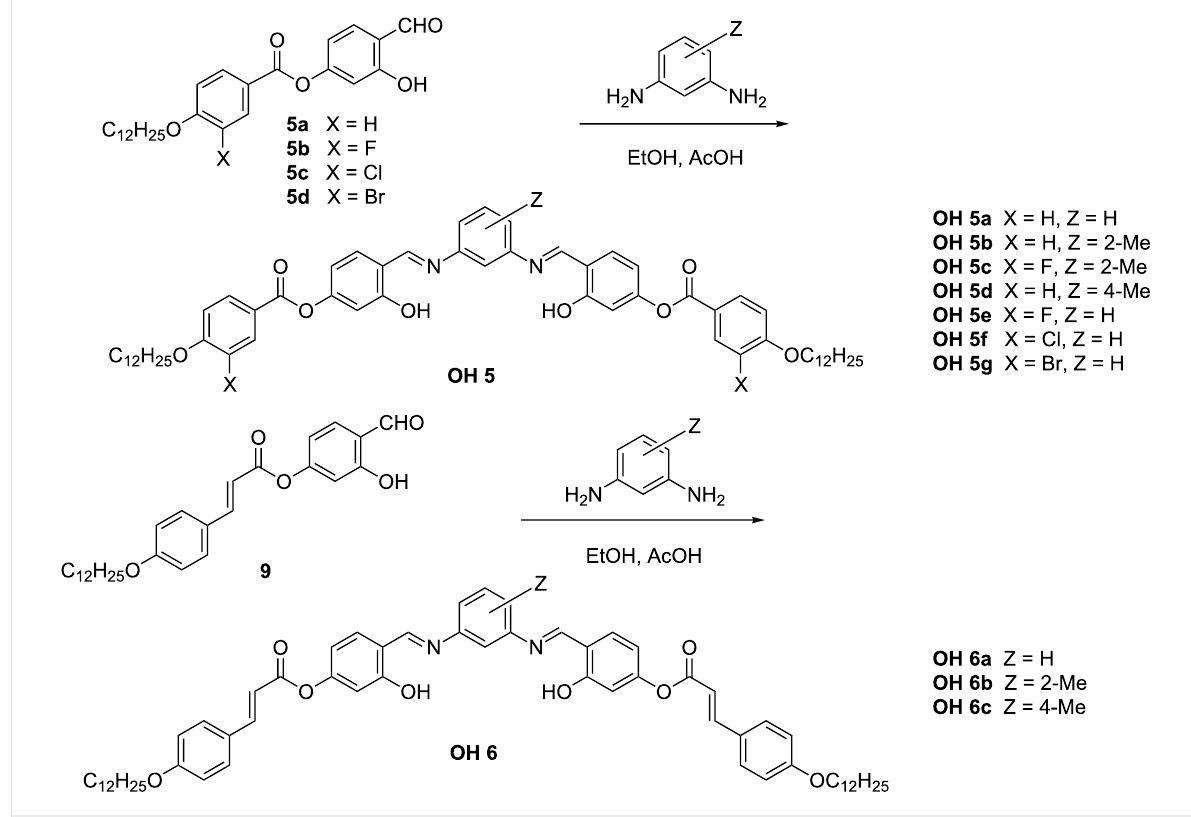
Table 5. For comparison, corresponding compounds having the same aromatic core but without the hydroxy groups are